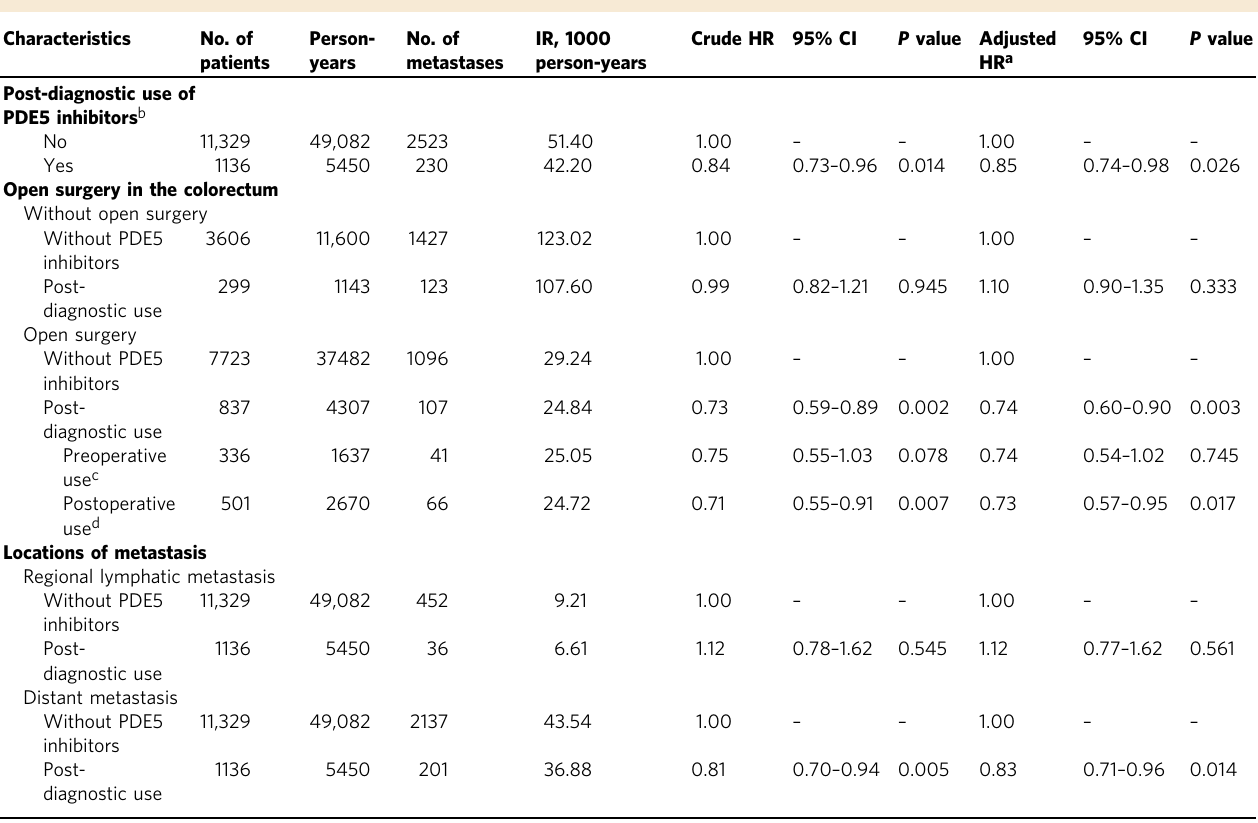
Table 3 Association of metastasis with PDE5